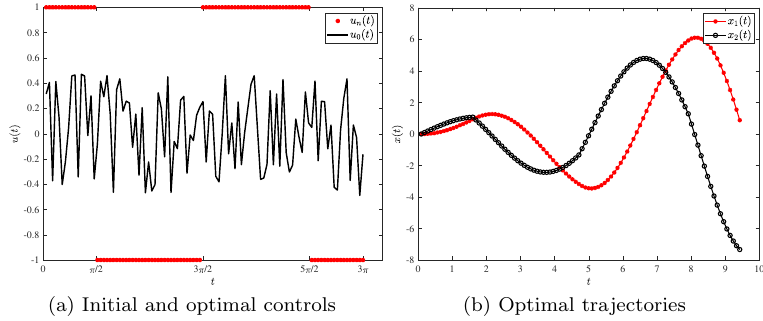
(b) Optimal trajectories Figure 3. Numerical results for Example 3.